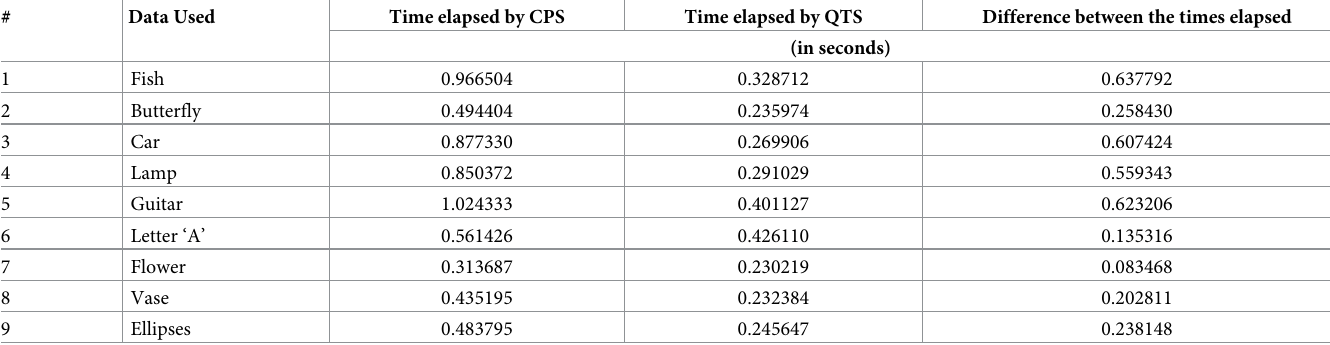
Table 2. Table of time elapsed of both the splines.